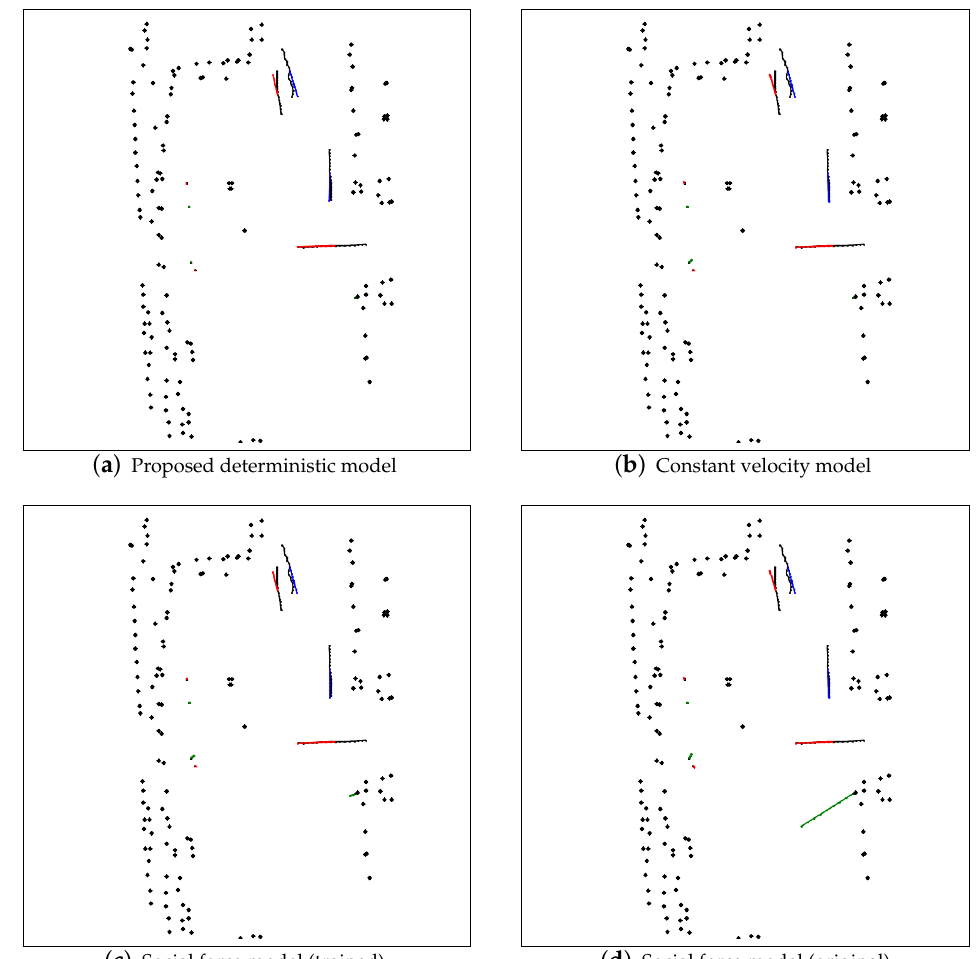
Figure 4. Graphical result of the compared deterministic